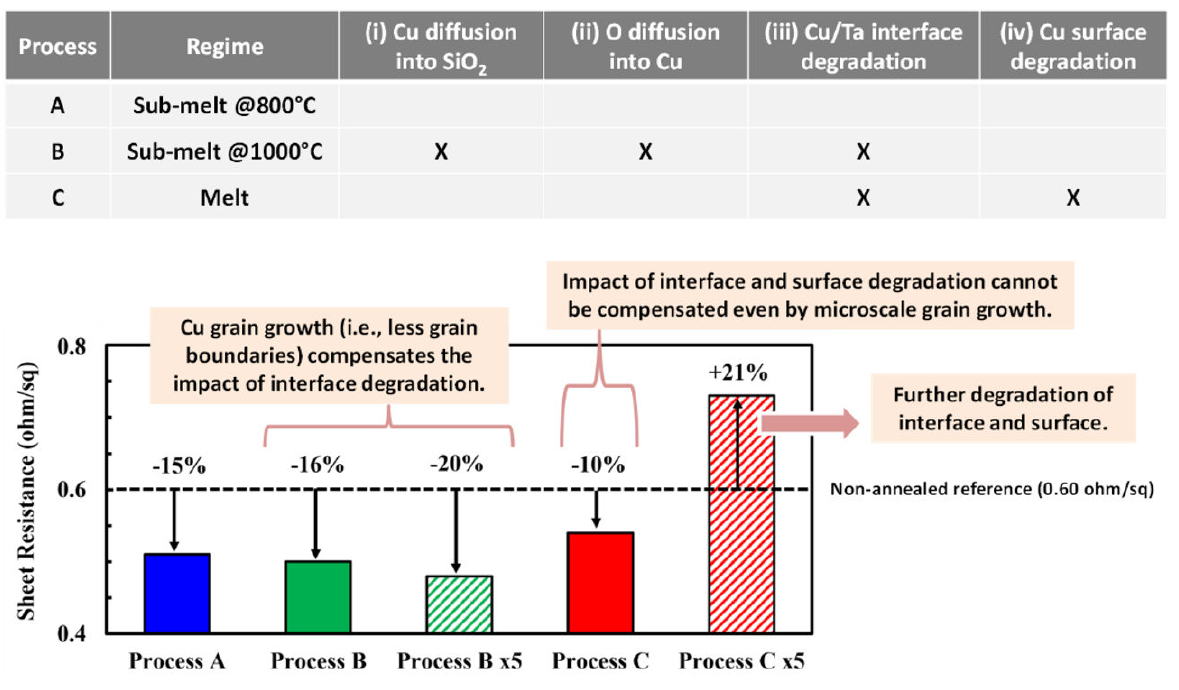
Figure 16. Sheet resistance measured in the Cu-based BEOL blanket structure (dielectric/Cu/Ta/SiO 2 /Si substrate) before and after µ s UV-LA (Processes A, B, and C). Reprinted/adapted with permission from Ref. [80]. 2022,